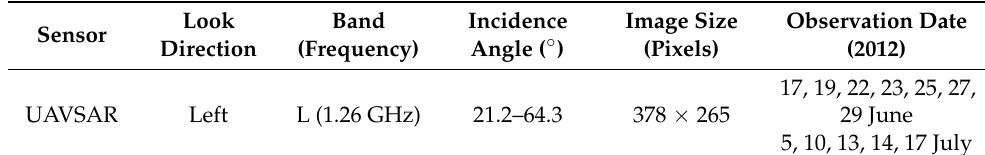
Table 1. Description of the UAVSAR time-series images.